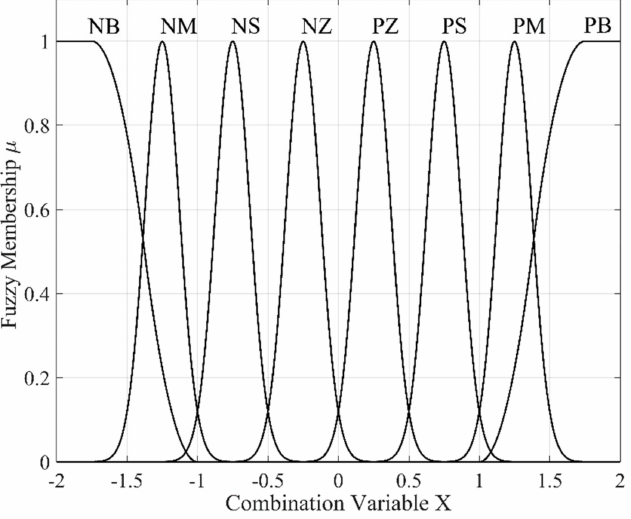
Figure 2. Composite membership function